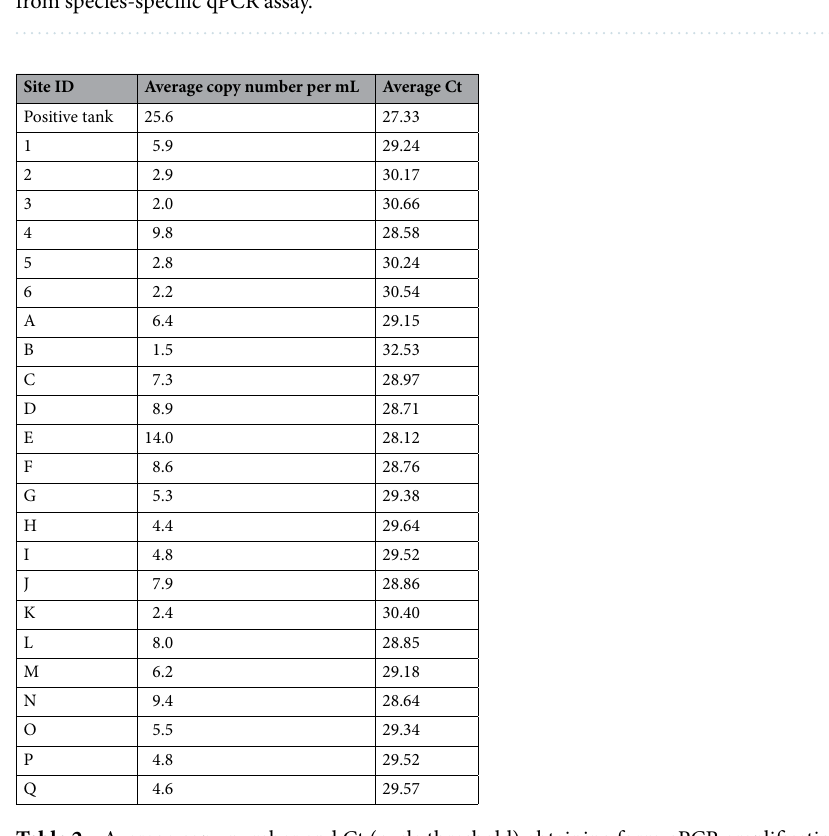
Table 2. Average copy number and Ct (cycle threshold) obtaining form qPCR amplification of DNA samples from all sampling sites and standard fragments. Average values were calculated from three qPCR replicates with each replicate contain three replicates of each